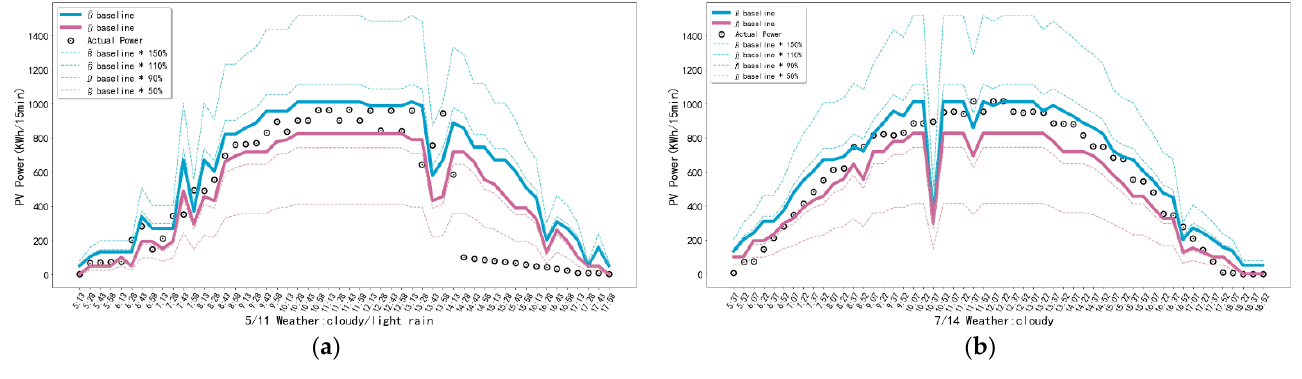
Figure 7. Performance Evaluation of ( a ) 2018/5/11 and ( b ) 2018/7/14 .